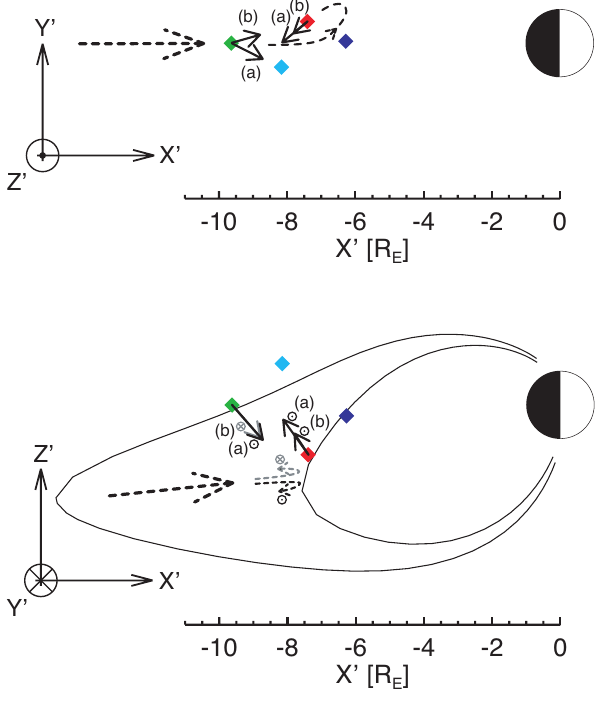
Fig. 5. Illustration of a flow vortex pattern in X 0 − Y 0 and X 0 − Z 0 planes. Big dashed arrows represent the source earthward flow. Small dashed arrows and lines illustrate plasma flows near the earth- ward edge of the earthward flow channel. Solid arrows indicate the directions of the observed flows for the intervals (a) and (b). The Y-components of the flows in the X 0 − Z 0 plane are denoted by the marks adjacent to the arrows. Diamonds represent THEMIS positions. Solid curved lines in the X 0 − Z 0 plane panel illustrate stretched and dipole-like magnetic fields.